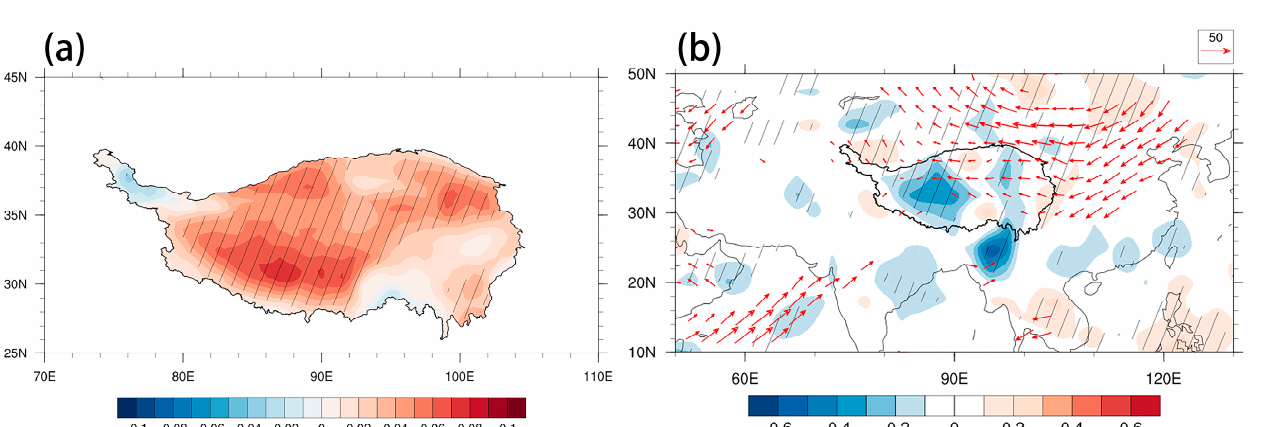
Figure 4. The difference in SH, LH, SWR, LWR, DSWR, LSWR, DLWR, ULWR, and G between 1997– 2018 and 1981–1995 over the TP (W m − 2 ).